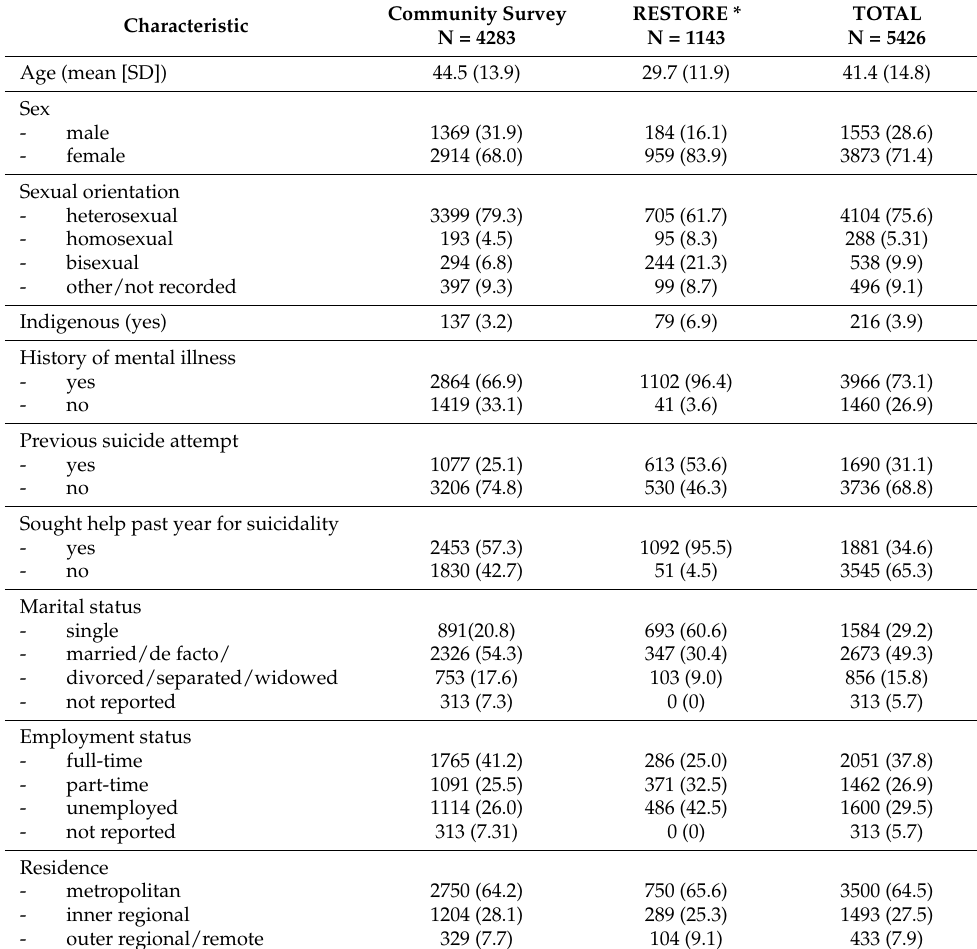
Table 1. Characteristics of the study population.